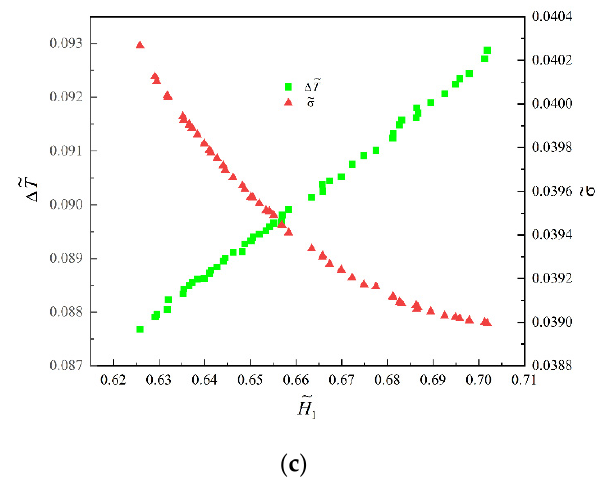
Figure 7. Distributions of ( a – c ) in the Pareto frontiers under three-DOF optimization.